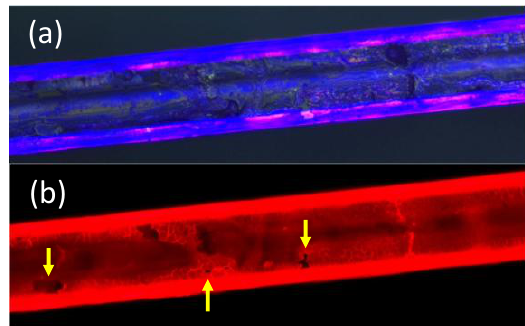
Figure 6. Images of one sample of D-shaped fibre cracking due to handling and bending: ( a ) optical micrograph showing intense interference colours and ( b ) fluorescence image after adding Rhodamine B. Cracks and defects are readily visible. In small regions where the layer has come off, these are dark and marked with yellow